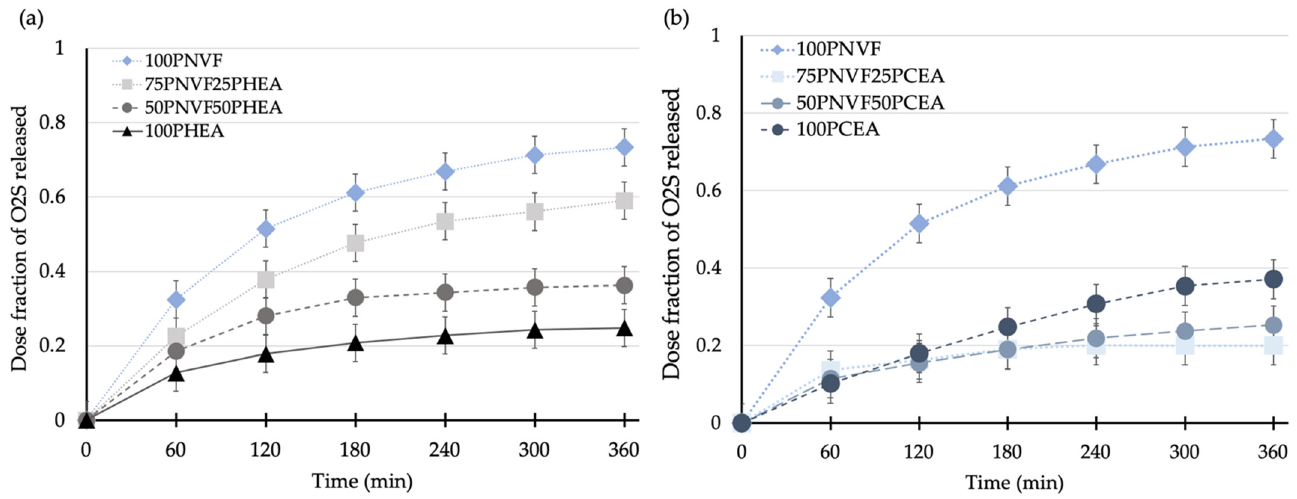
Figure 6. Release profiles of ( a ) P(NVF-co-HEA) hydrogel series and ( b ) P(NVF-co-CEA) hydrogel series with 0.0001M orange II sodium salt dye solution. series with 0.0001 M orange II sodium salt dye